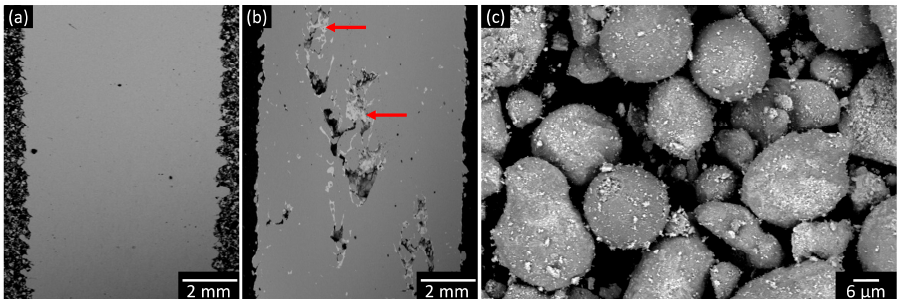
Figure 3. SEM micrographs for: ( a ) an unreinforced 316L specimen synthesized by SLM at 688 mm/s; ( b ) a 316L/CeO 2 composite synthesized at 688 mm/s; and ( c ) 316L/CeO 2 powder mixture ball milled for 2 h. The bright contrast indicated by red arrows in (b) and the small bright particles adhering to the large 316L particles in (c) are the CeO 2 phase.